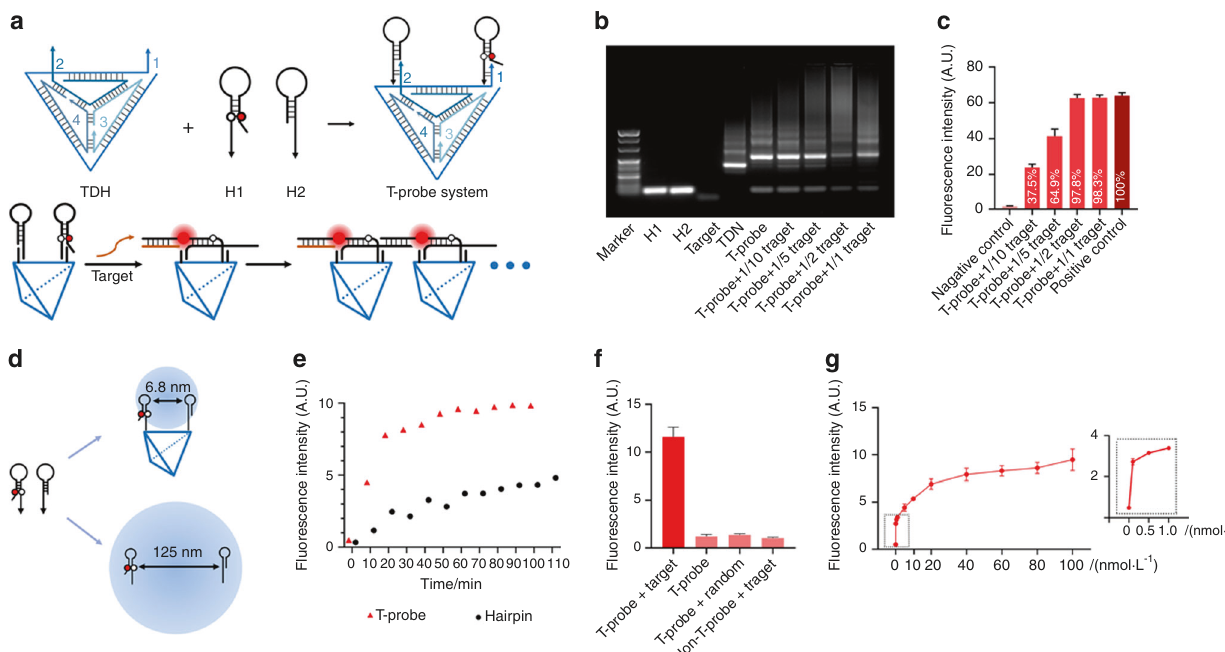
Fig. 7 DNA hairpin-endowed biosensors. a Schematic illustration of a DNA tetrahedron (TDN)-based biosensor (T-probe) and its enhanced imaging of the target via HCR. The red dot indicates the Cy5 module; the white dot indicates the BHQ module. b Agarose gel electrophoresis image of the fabrication and HCR assay. c Fluorescence intensity responses of the T-probe exposed to the target at different molecular ratios. d Comparison of the reaction distance between naked DNA hairpins and the T-probe. e The time-dependent intensity of the T-probe suggests that it is a rapid sensor platform. f and g Speci fi city and sensitivity evaluation of the T-probe system. 125 Copyright 2022, John Wiley and